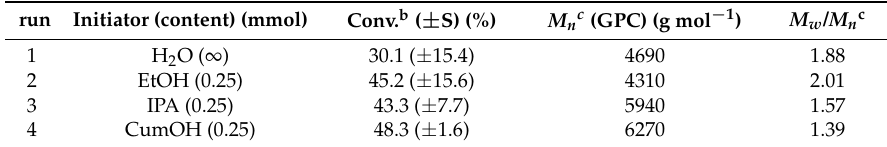
Table 1. Suspension cationic polymerization of isobutyl vinyl ether (IBVE) in the presence of different initiators a.